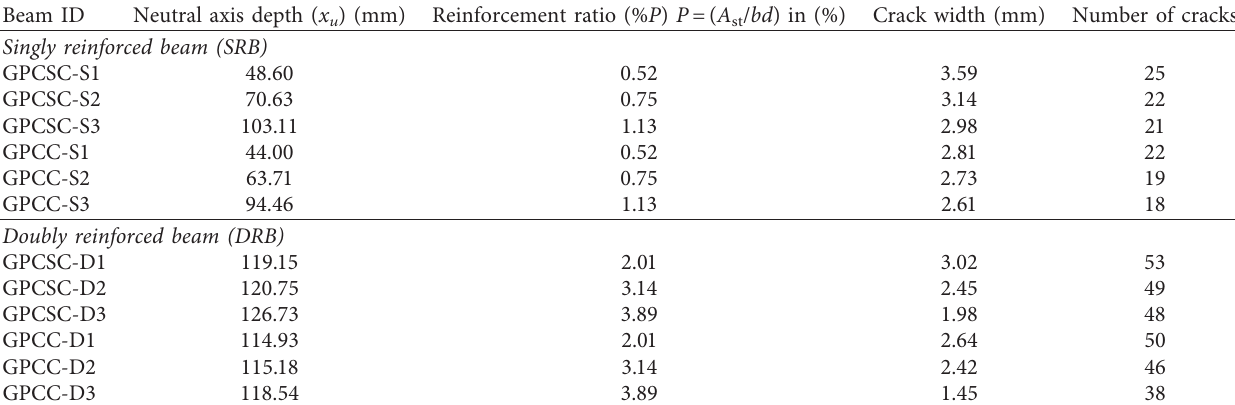
Table 5: Crack width, reinforcement ratio, and number of cracks.